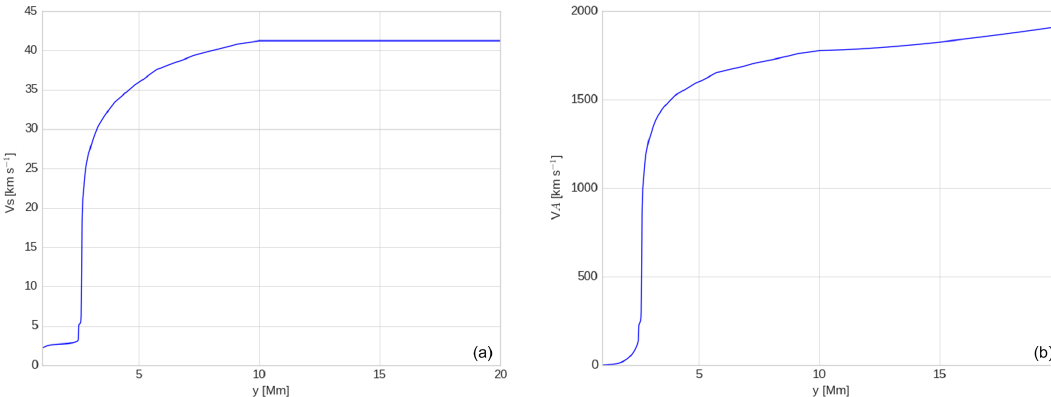
Figure 5. Sound speed (a) and Alfvén speed (b) vs. height ( y ) in the model quiet solar atmosphere.